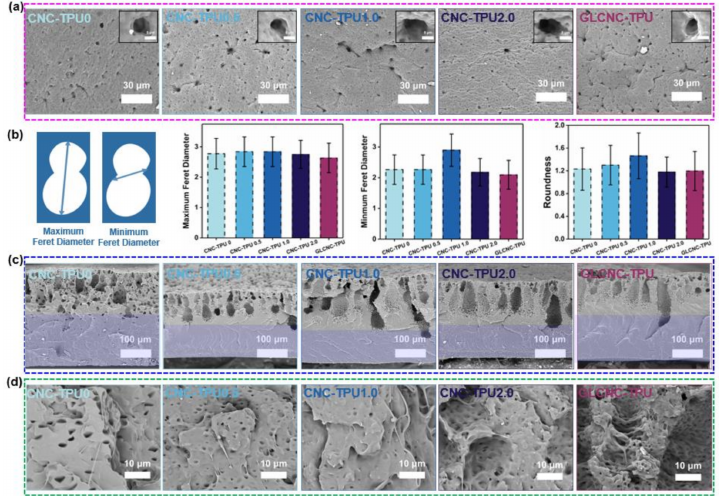
Figure 9. ( a ) SEM images of the surfaces of CNC/TPU and GLCNC-TPU composite films; ( b ) maximum Feret diameter, minimum Feret diameter, and roundness of pores on the surface of CNC/TPU and GLCNC-TPU composite films; ( c ) freeze-fractured and ( d ) tensile-fractured cross- section surfaces of CNC/TPU and GLCNC-TPU composite